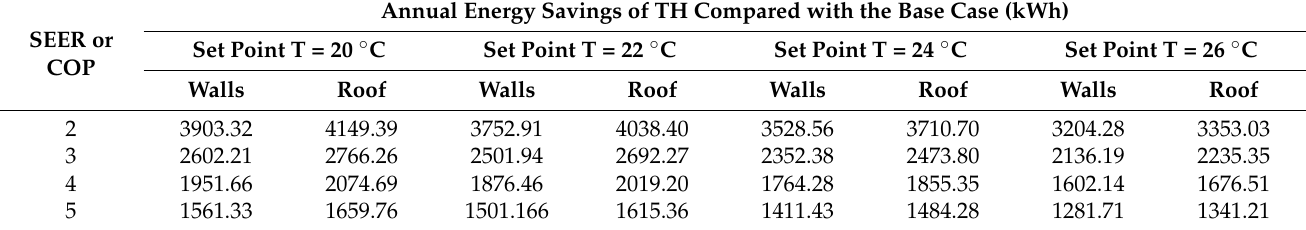
Table 6. Annual cooling energy savings of townhouse with changes in AC setpoint and SEER.